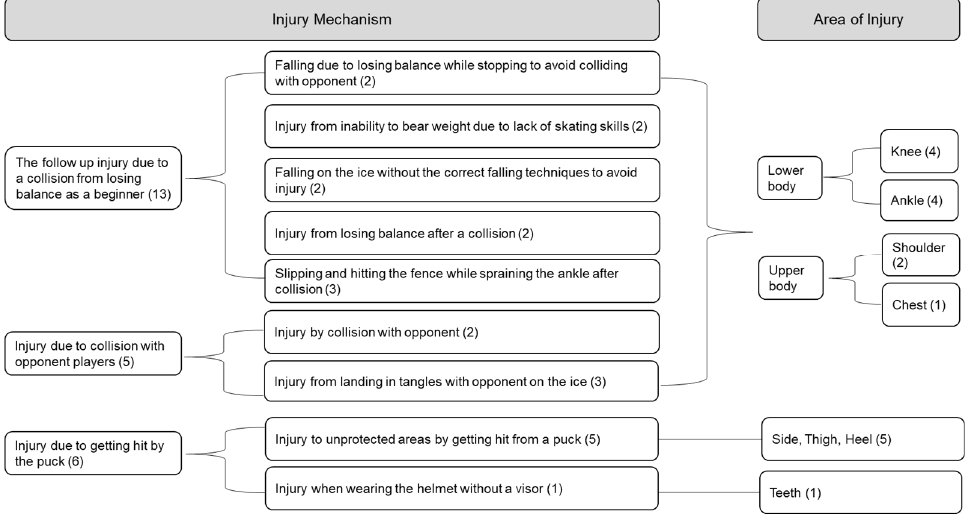
Figure 2. Injury mechanism and area of injuries (coding number in parenthesis).